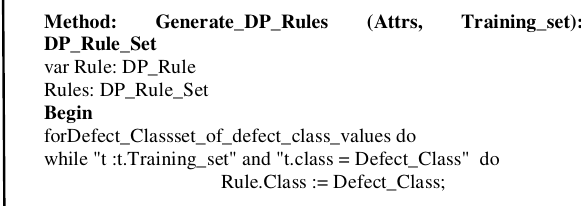
Algorithm-1: Regression-Based Learning